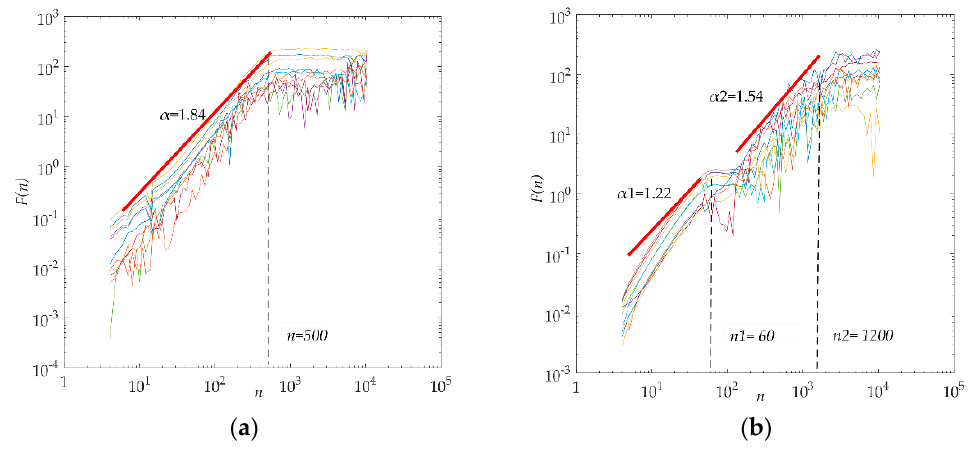
Figure 4. DCCA analysis of healthy controls ( a ) and hemiplegia patients ( b ).